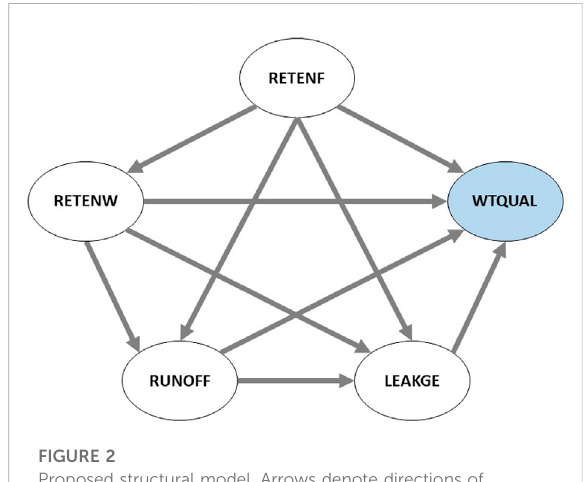
FIGURE 2 Proposed structural model. Arrows denote directions of hypothesized in fl